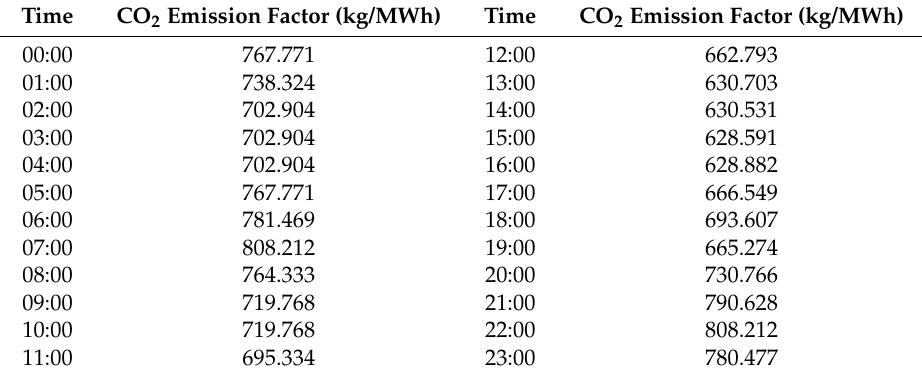
Table 5. Emission factors of CO 2 obtained from the Locational Emission Estimation Methodology (LEEM) server.